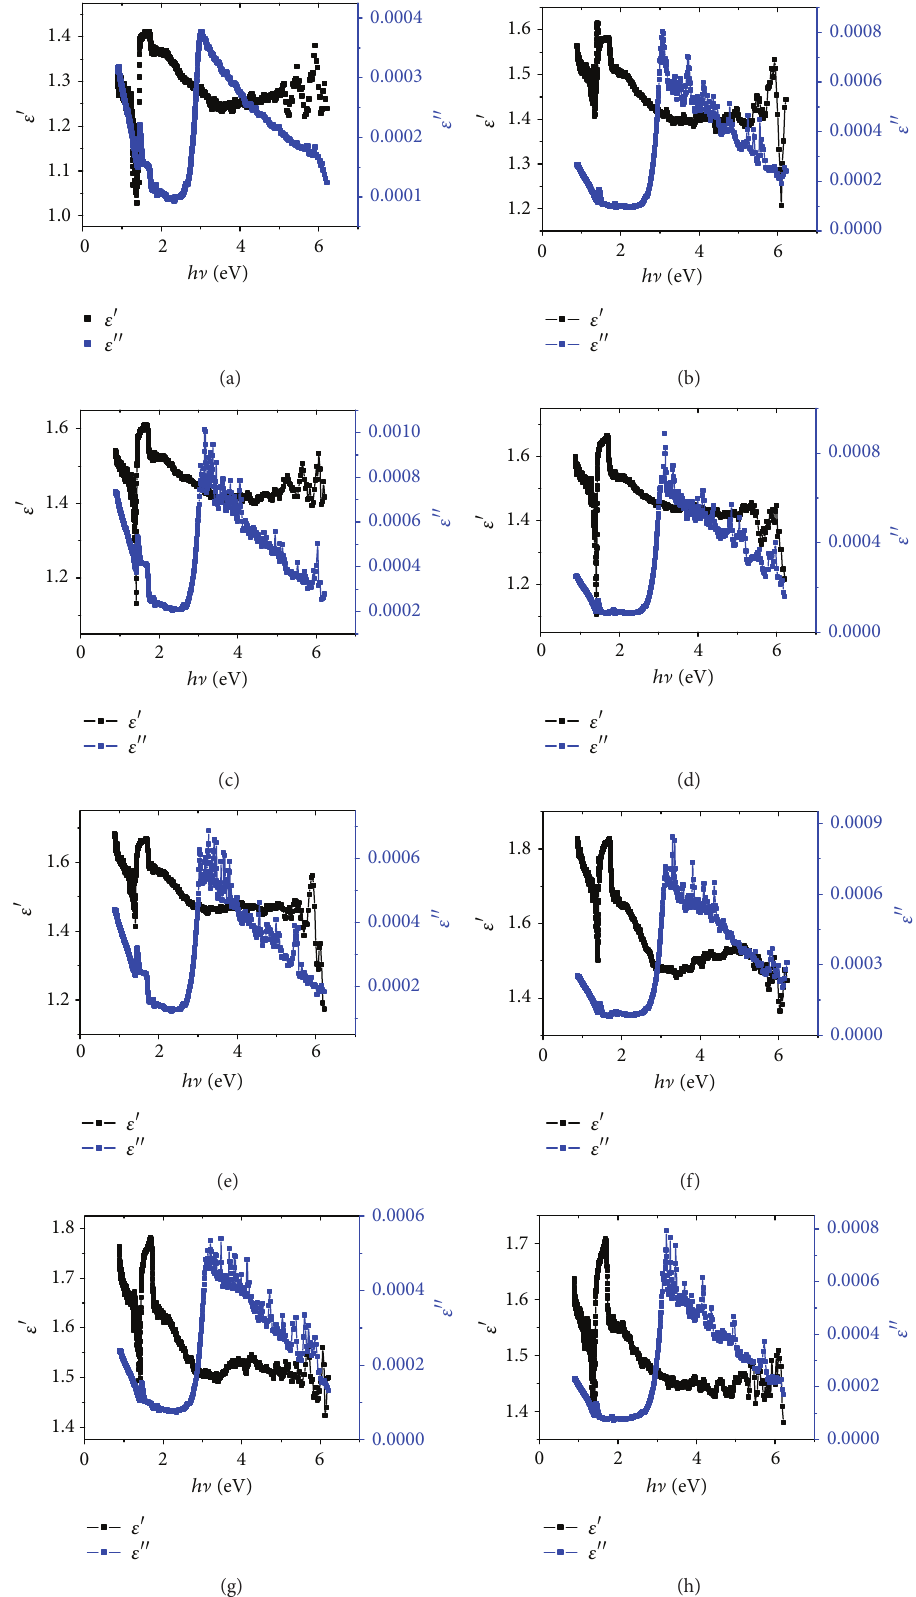
Figure 6: Variation of real ( 𝜀 󸀠 ) and imaginary ( 𝜀 󸀠󸀠 ) parts of complex dielectric constants of 40SiO 2 ⋅ 𝑥 ZnO ⋅ ( 60 − 𝑥 )Bi 2 O 3 glass system for 𝑥 = 0 , 5, 10, 15, 20, 25, 30, and 35 in (a), (b), (c), (d), (e), (f), (g), and (h),